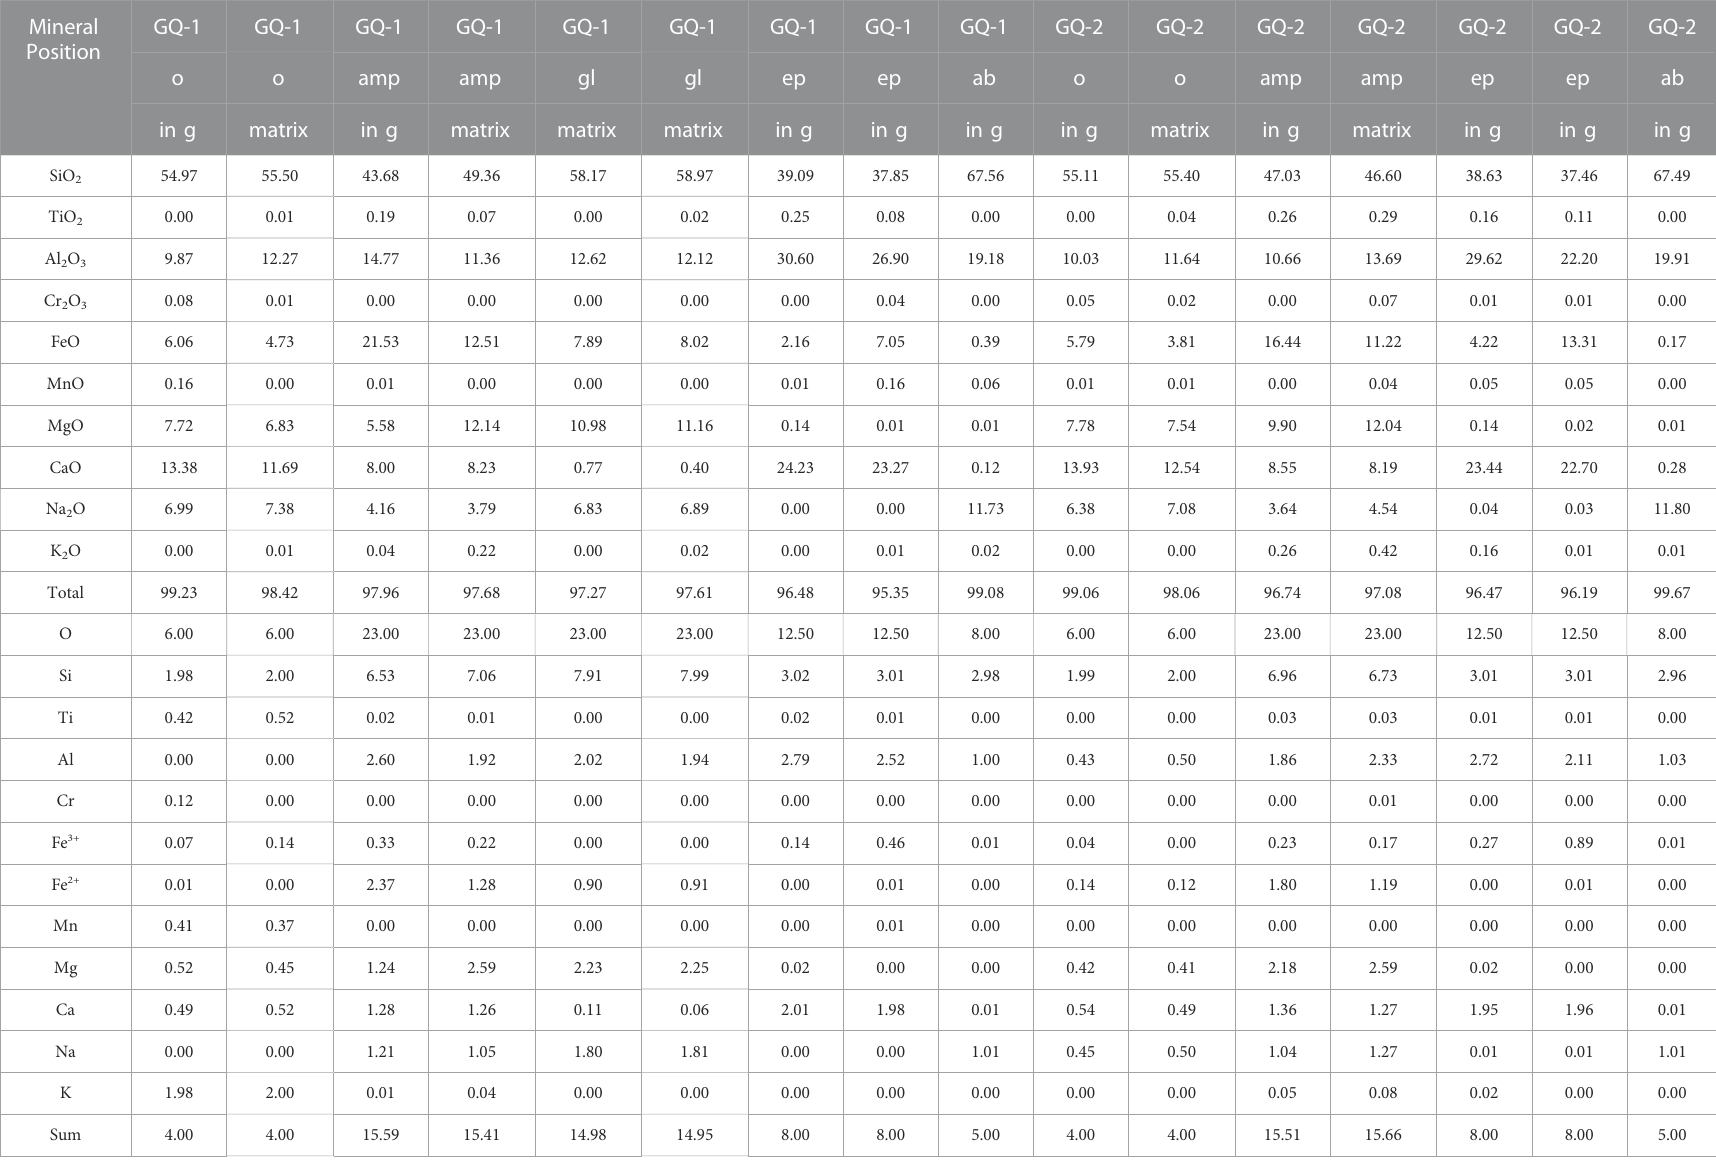
TABLE 2 Representative compositions of omphacite, amphibole albite and epidote from eclogite at Gaoqiao, western